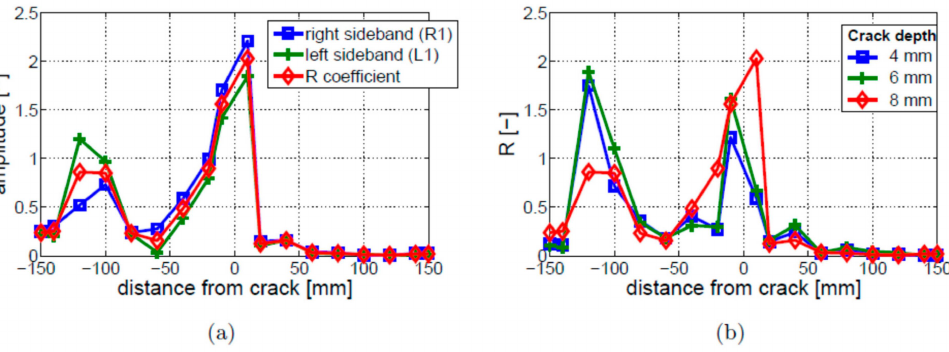
Figure 13. Parametric study of nonlinear vibro-acoustic modulations for the breathing crack model: ( a ) modulation intensity; ( b ) crack depth.